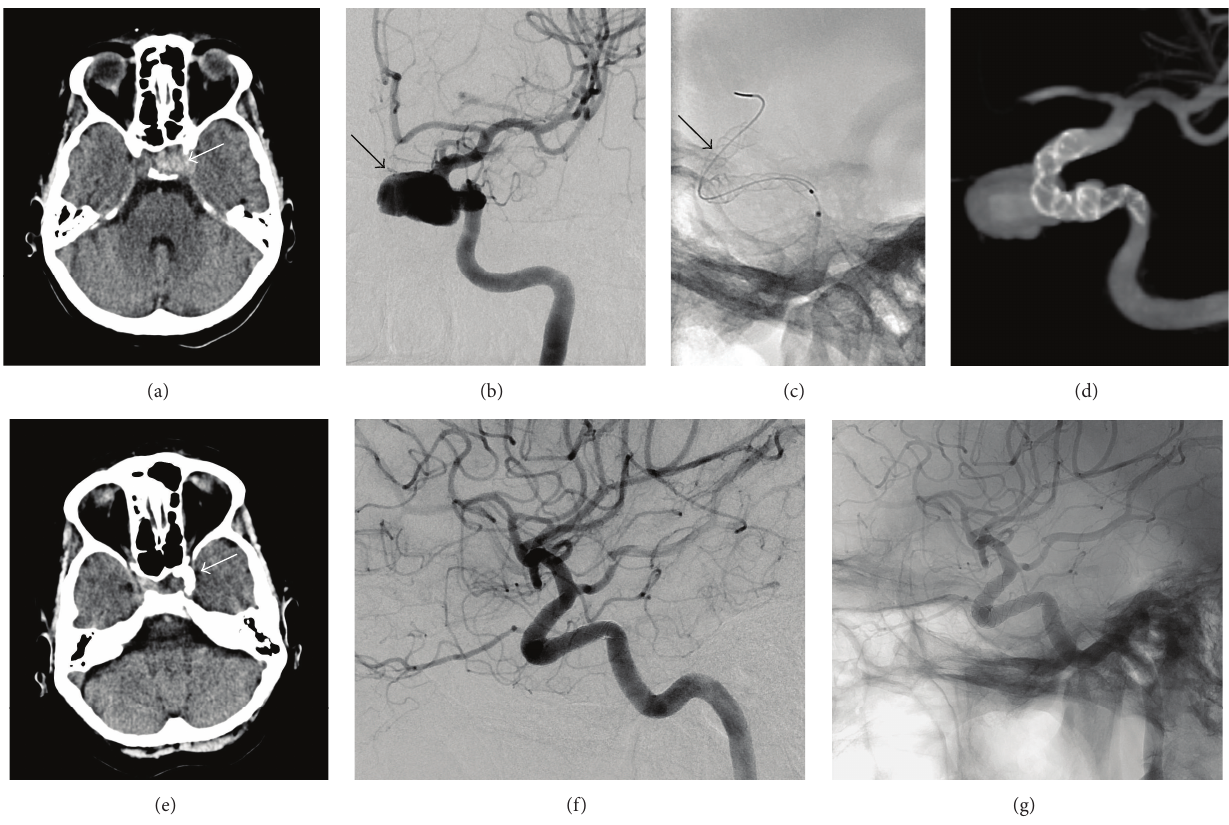
Figure1:Cranialnervepalsy(patientnumber1).55-year-oldwomanpresentedwithleftoculomotorpalsy.CranialCT(a)showedhyperdense mass in the ophthalmic segment of the left carotid artery. Wide-necked intracranial aneurysm was proved by digital subtraction angiography (DSA, b) and the patient was treated using a flow diverter (c, d). In follow-up, clinical symptoms improved; the mass (e) and DSA confirmed no filling of the aneurysm sack (f,